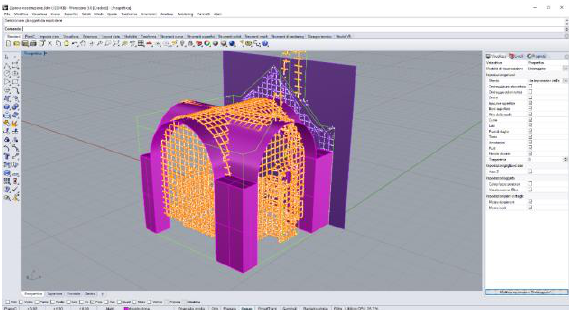
Figure 7. Realization of NURBS, surfaces from the point cloud with Rhinoceros